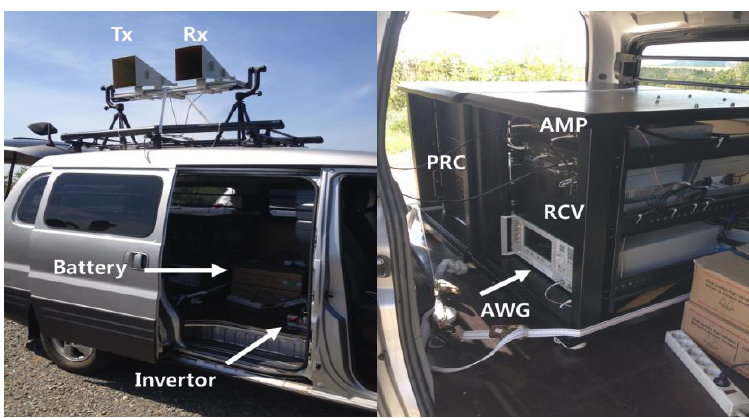
Figure 8. Test equipment on-board a commercial vehicle for ISAR experiment.